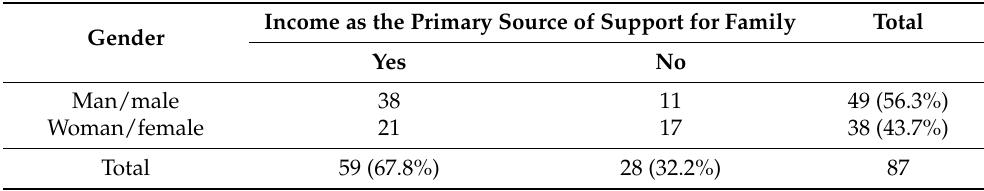
Table 2. Cross-tabulation of the respondents’ gender and role as primary income